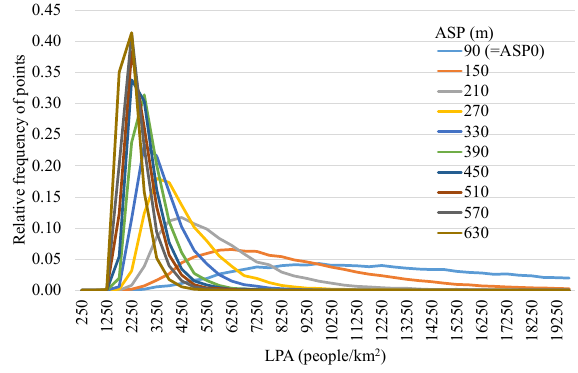
Figure 6 . Relative frequency distributions of LPA for individual ASPs in Osaka 2015.